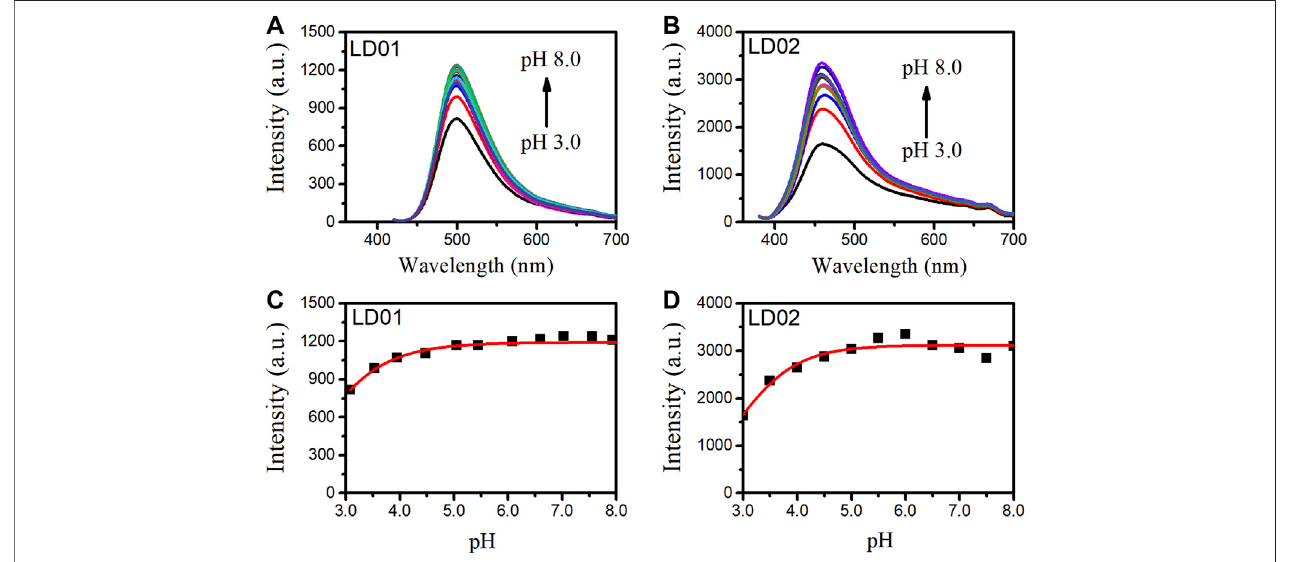
FIGURE 3 | Fluorescence spectra of LD01 (A) ( λ ex = 410 nm) and LD02 (B) ( λ ex = 365 nm) in buffers of various pH. Scatterplots of the most intense fl uorescence emission by LD01 (C) and LD02 (D) in (A, B) .